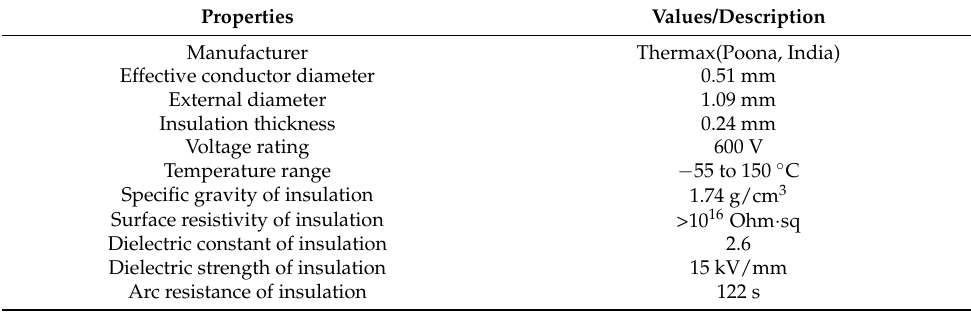
Table 1. Properties of the studied extruded ETFE insulated wire samples.